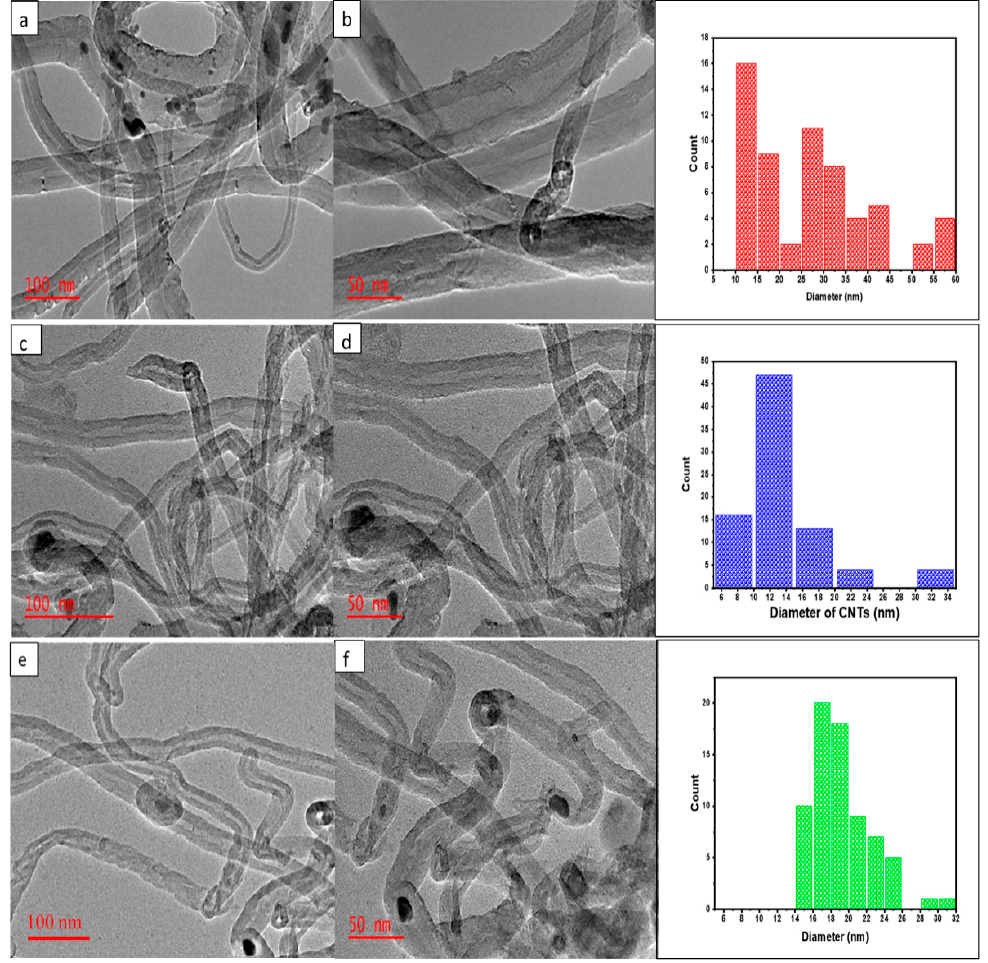
Figure 9. TEM images and outer diameter distribution of the as-synthesized CNTs over NiMo/CaTiO 3 (NMC412) catalysts prepared at different calcination temperatures: ( a , b ) 600 °C, ( c , d ) 700 °C, and ( e , f ) 800 °C.